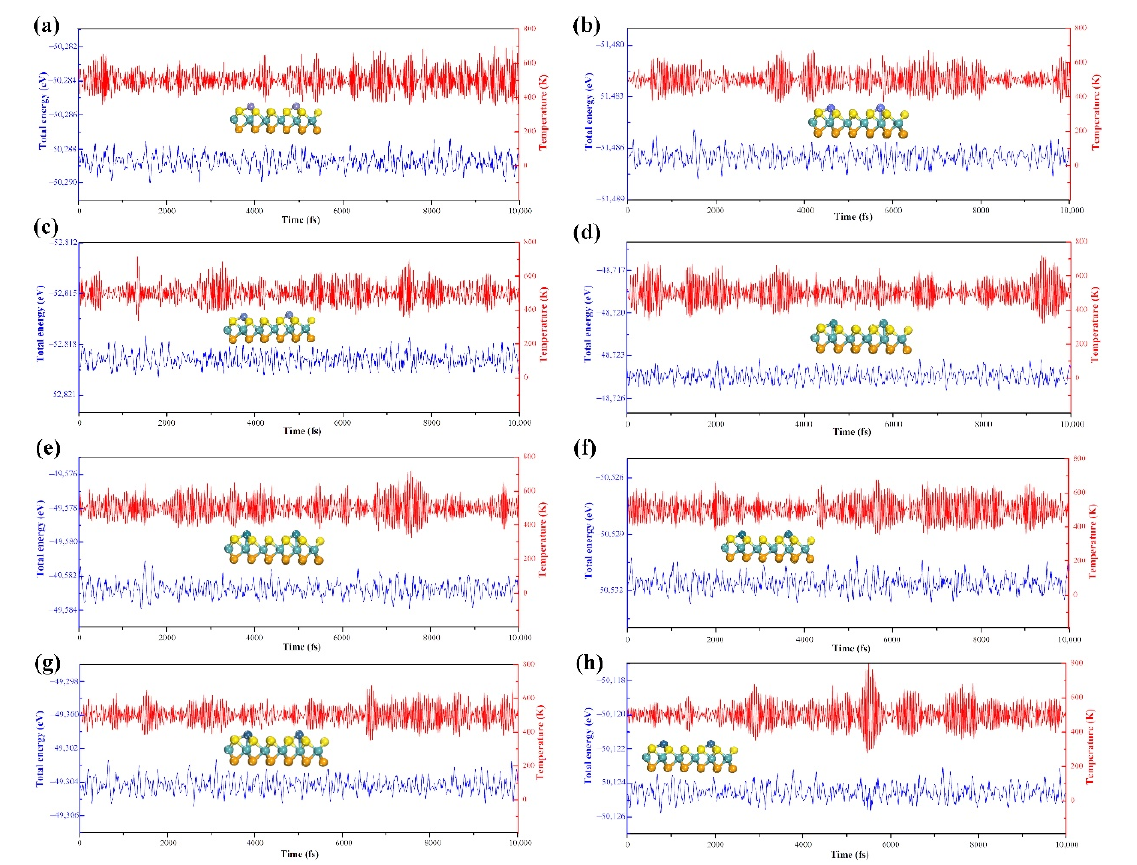
Figure 2. Variations of temperature and energy of against the time for the AIMD simulations of ( a ) Fe, ( b ) Co, ( c ) Ni, ( d ) Ru, ( e ) Rh, ( f ) Pd, ( g ) Ir, and ( h ) Pt@MoSSe. The simulation was run under 500 K for 10 ps with a time step of 1 fs.